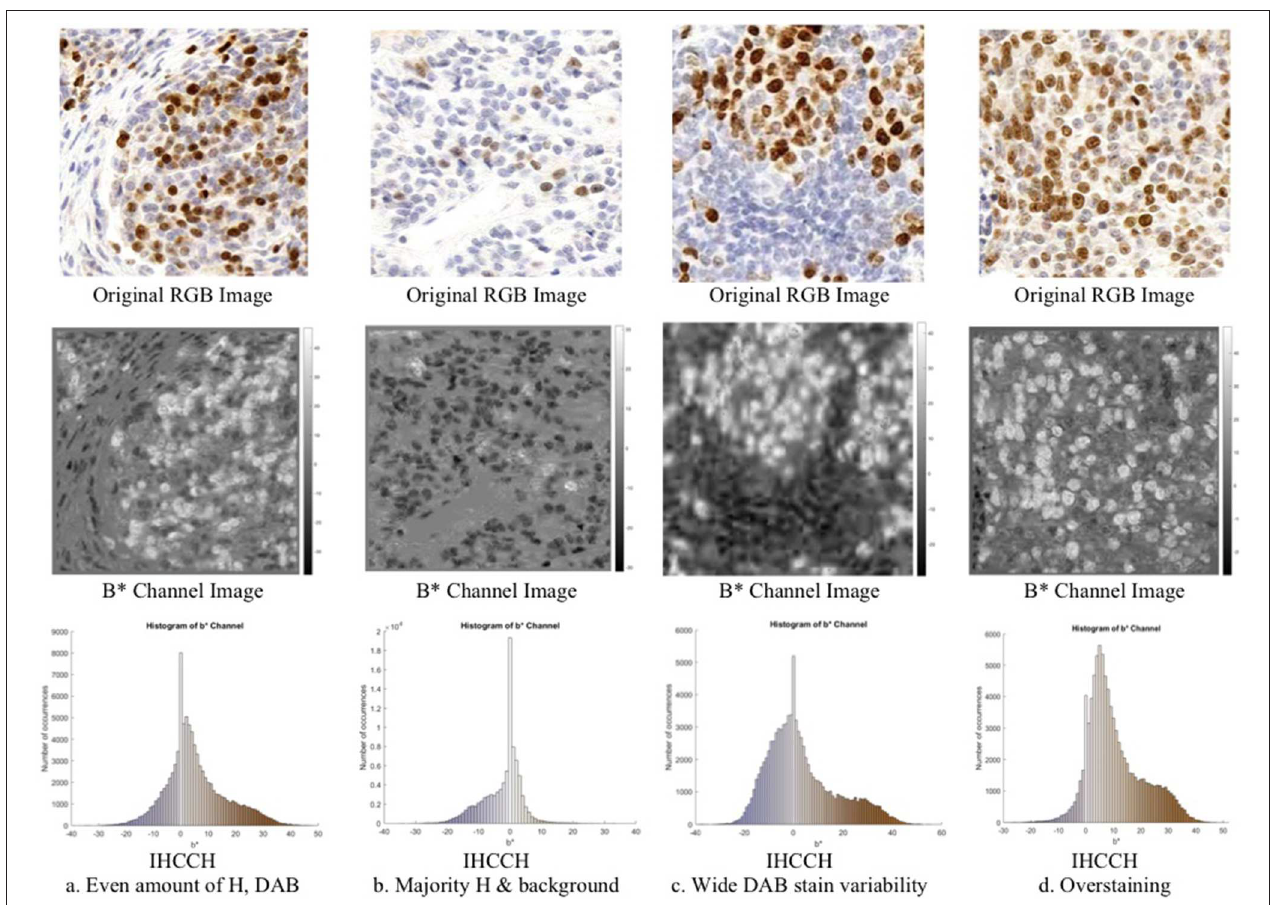
FIGURE 3 | Region of interest from OVC dataset of Ki67 TMAs ( top ) with corresponding b *channel images ( middle ) and IHCCH plots ( bottom